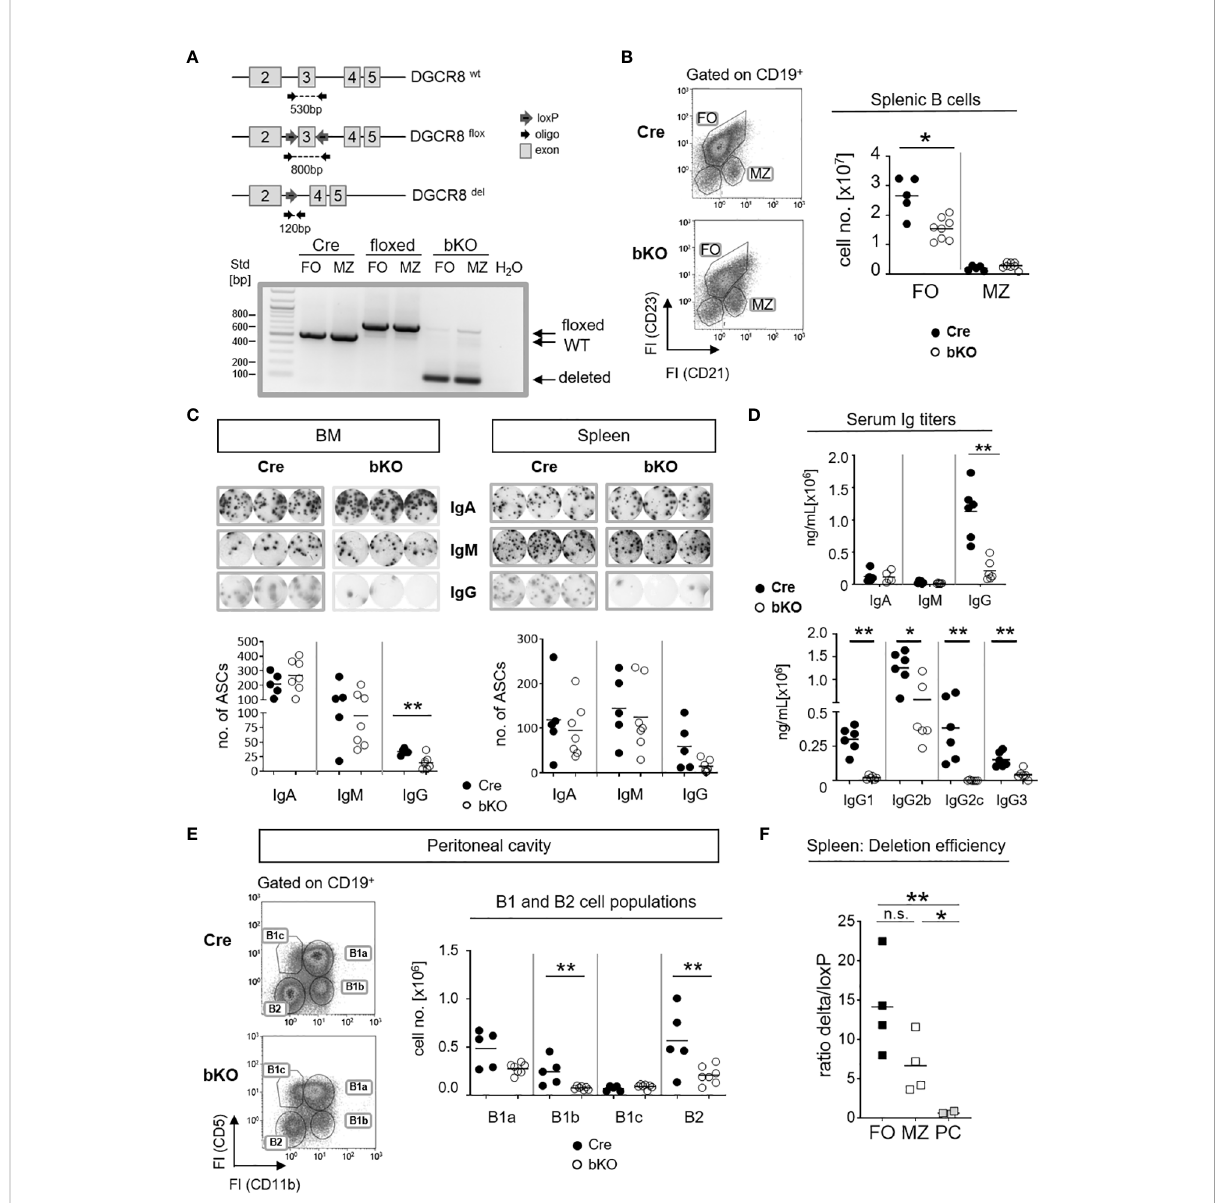
FIGURE 1 B cell-speci fi c DGCR8 de fi ciency impairs the establishment of mature B cells and IgG-secreting cells in vivo . (A) Construction of a mouse carrying a DGCR8 allele with a fl oxed exon 3 (upper panel). The locus was analyzed by PCR of fl ow cytometry-sorted MZ B cells (B220 + CD19 + CD93 - CD23 low CD21 + ) and FO B cells (B220 + CD19 + CD93 - CD23 + CD21 low ) from DGCR8-bKO, Cre-only and fl oxed-only control mice, respectively. PCR product/amplicon sizes are ~530 bp for the wildtype, ~800 bp for the fl oxed and ~120 bp for the Cre-deleted DGCR8 allele. (B) Flow cytometry analysis of splenic B cells from DGCR8-bKO (bKO) and Cre control mice. Stained samples were pre-gated on CD19- positive cells. Cell numbers of MZ- and FO B cells in the total spleen cell populations were quanti fi ed by fl ow cytometry using fl ow count beads. Bars indicate the median of n=5 (Cre) or n=8 (bKO) mice. (C) ELISpot assay to quantify IgA, IgM or IgG-secreting cells in the bone marrow (BM; left panel) and the spleen (right panel) from non-immunized DGCR8-bKO and Cre control animals. Depicted wells show the results from a total of 3,33x10 4 seeded cells. (D) Serum samples from non-immunized DGCR8-bKO and Cre control mice of 9-18 weeks in age were analyzed by ELISA for total IgA, IgM, IgG and IgG-subclasses. n=6 mice of each genotype. (E) Flow cytometry analysis of samples from peritoneal lavages of DGCR8-bKO and Cre control mice to quantify B1a (CD19 + CD5 + CD11b + ), B1b (CD19 + CD5 - CD11b + ), B1c (CD19 + CD5 + CD11b - ) and B2 (CD19 + CD5 - CD11b - ) cell populations. Cell numbers were calculated per total lavage. (F) Cre-mediated DGCR8-deletion ef fi ciency was analyzed by quantifying PCR amplicon abundances of the loxP- fl anked and the deleted DGCR8-allele from sorted FO, MZ and CD138 + TACI + - populations of DGCR8-bKO mice (Figure 1A and Supplemental Figure 1A). Displayed is the ratio between the deleted allele and the loxP- fl anked allele in the same sample. Amplicon abundances were quanti fi ed by ImageJ. Bars indicate the median of (B-E) n=5 (Cre) or n=7 (bKO) mice and (F) n=4 mice. Each dot represents one mouse. Mann-Whitney test was used for statistical analysis. **p<0.01; * p<0.05, n.s., not signi fi